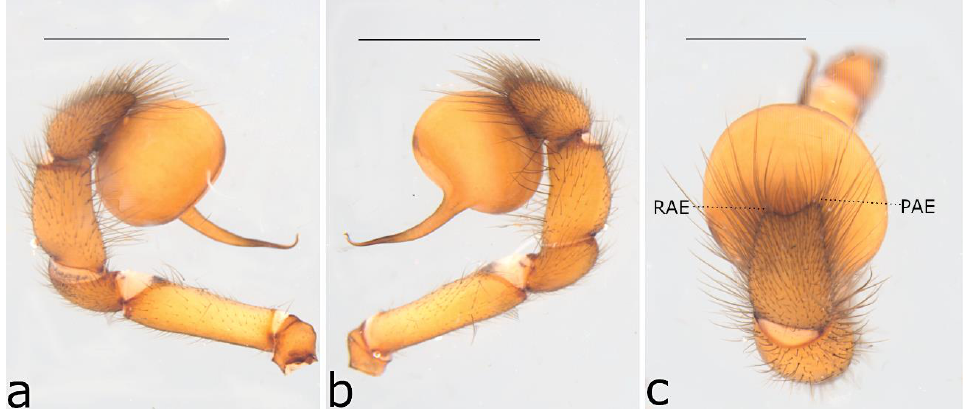
Figure 70. Ariadna valida sp. nov. ♂ holotype (SAMA NN10579) from near Illintjitja (SA): ( a ) right pedipalp (mirrored), prolateral view; ( b ) same, retrolateral view; ( c ) same, cymbium. Scale bar = ( a , b ) = 2 mm and ( c ) = 1 mm.